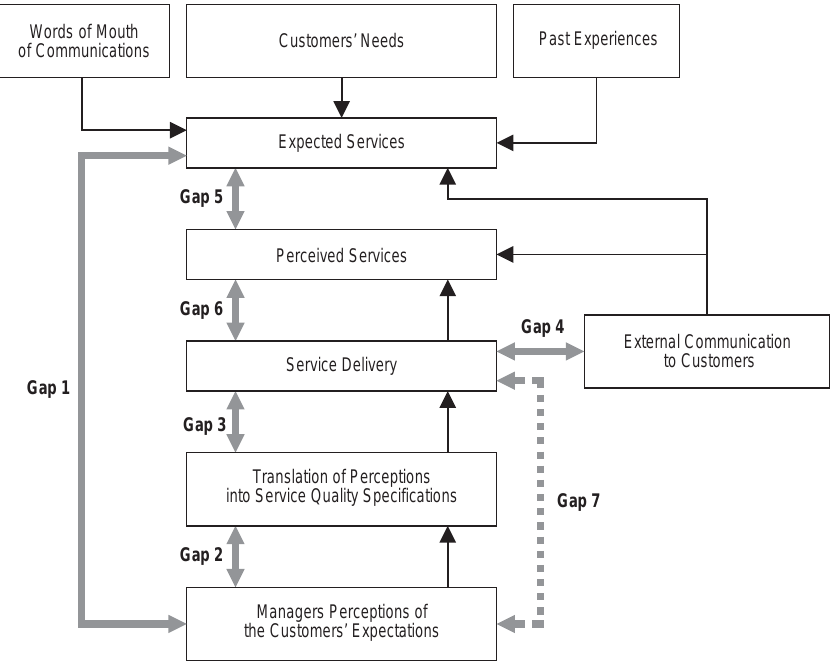
Fig. 3. Adjusted Gap model. Source: Parasuraman et al. (1985)